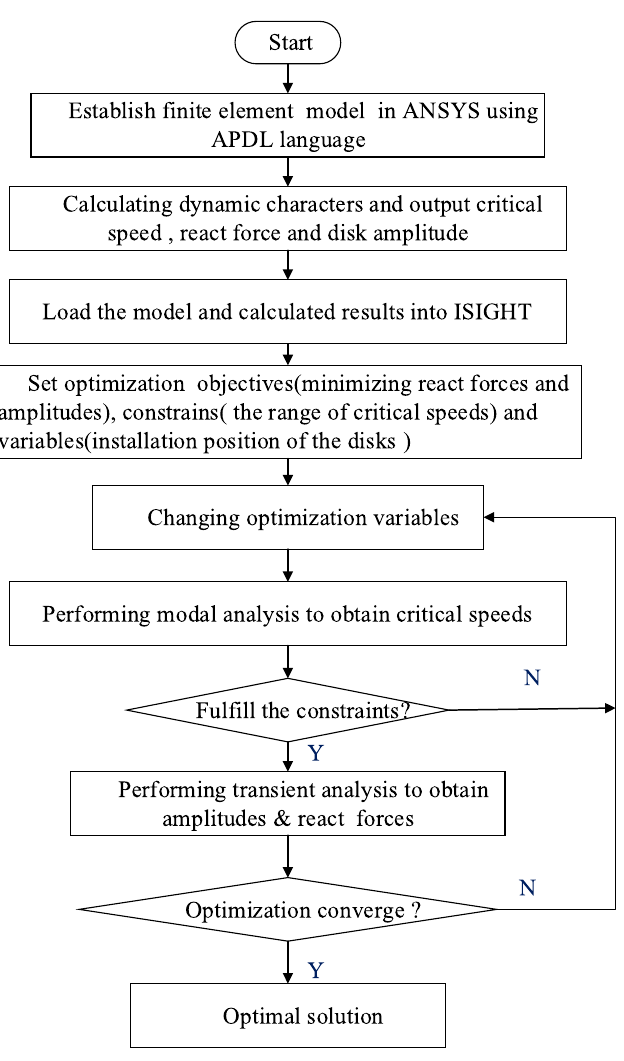
Fig. 4. fl ow chart of the optimization design